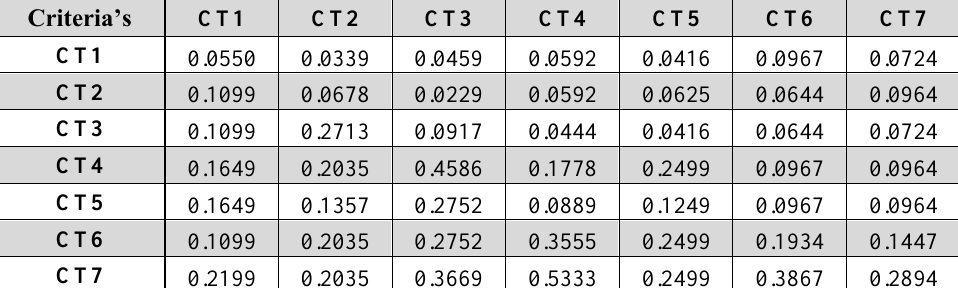
Table 4. Calculating the